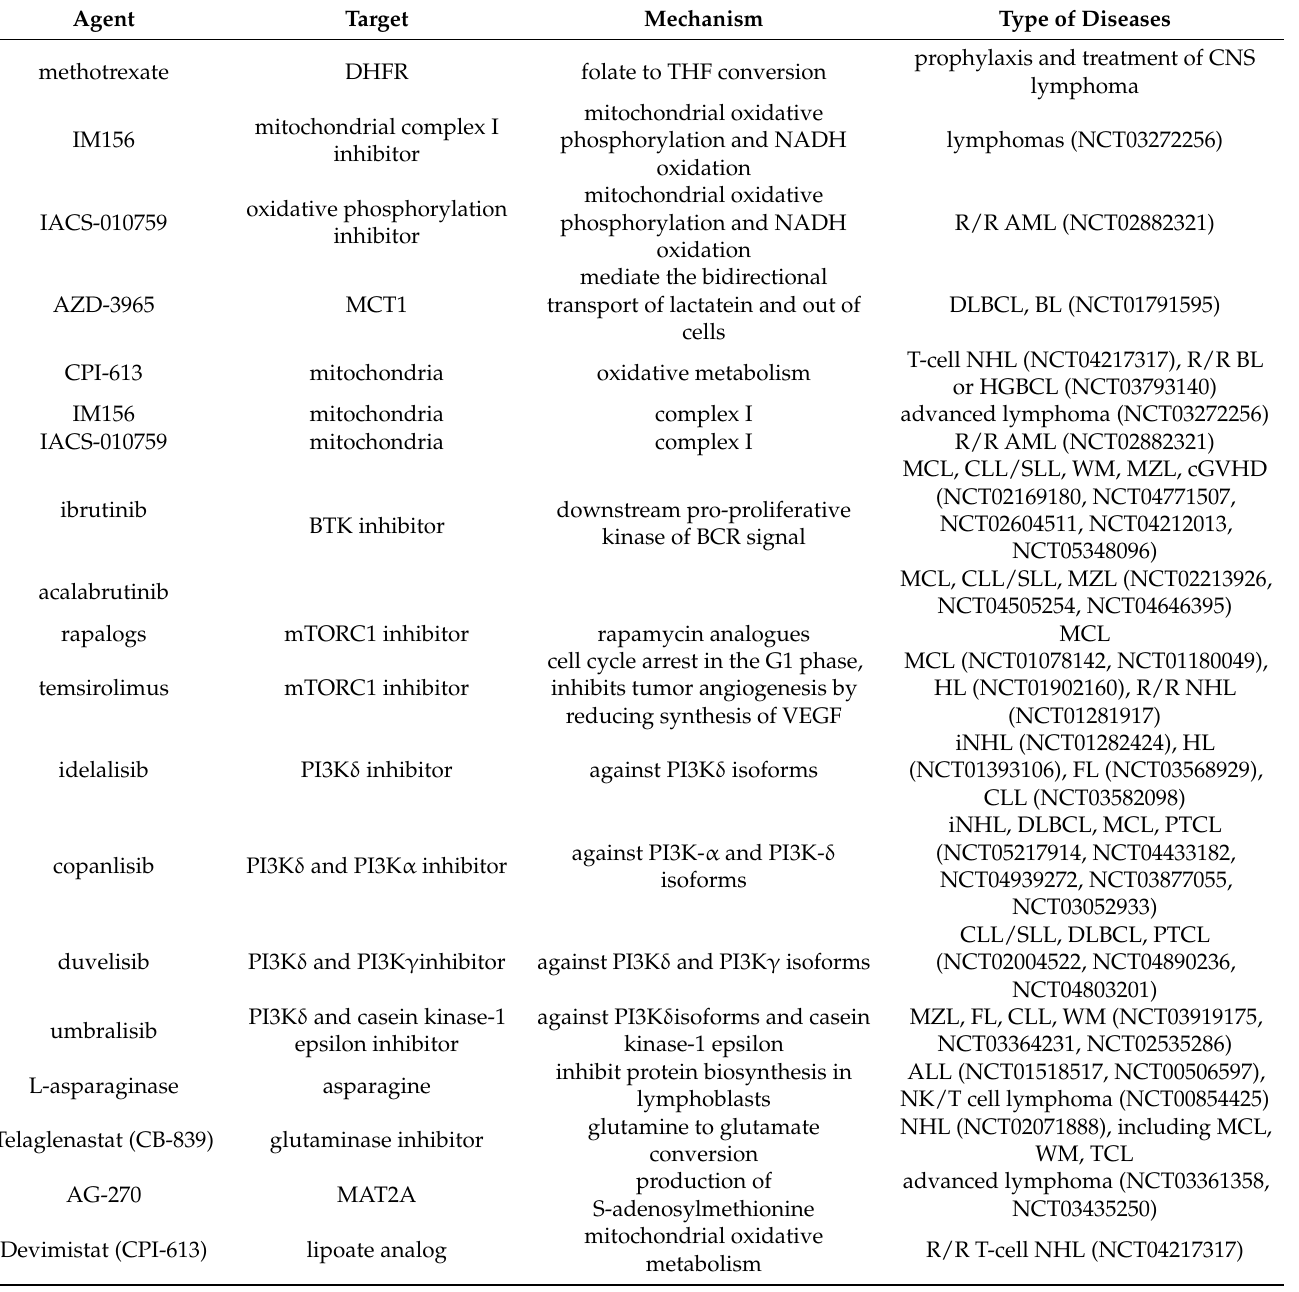
Table 2. Primary approved drugs and ongoing clinical trials targeting lymphoma